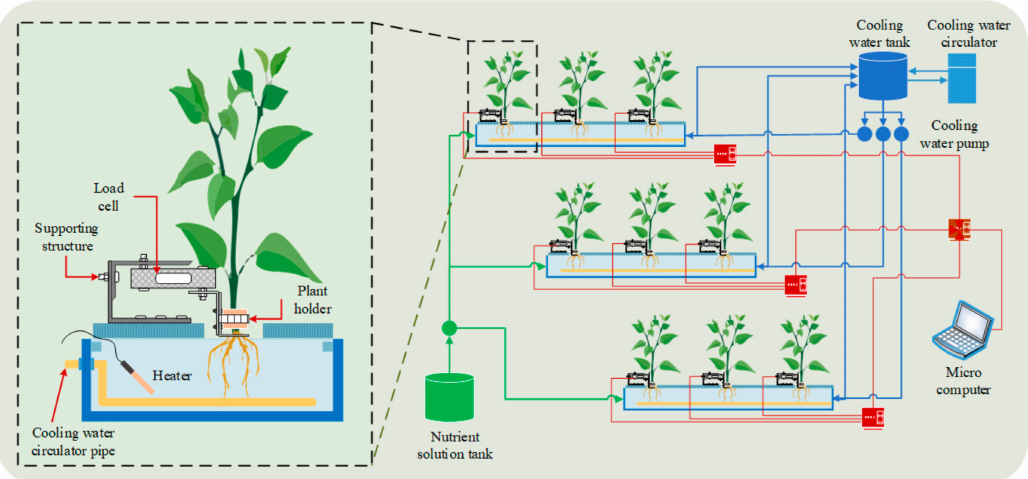
Figure 1. Root zone temperature control system and plant growth measuring system using a load cell